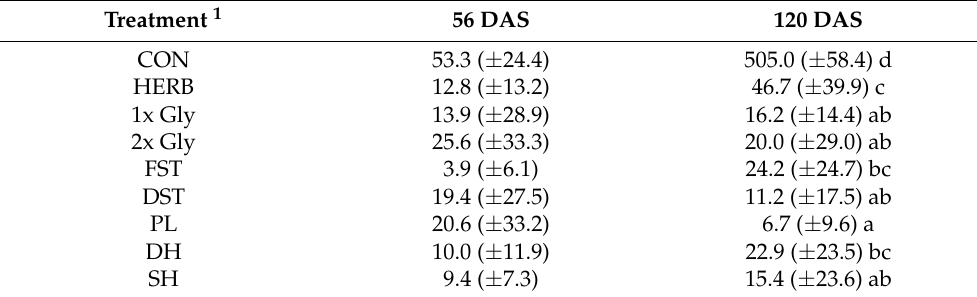
Table 4. A. myosuroides density (plants m − 2 ) 56 DAS and 120 DAS at Binsen. Levels of significance are shown behind the result for each date separately. Means with the same letter are not significantly different according to HSD test at p ≤ 0.05. Levels of significance are shown behind the result for each date